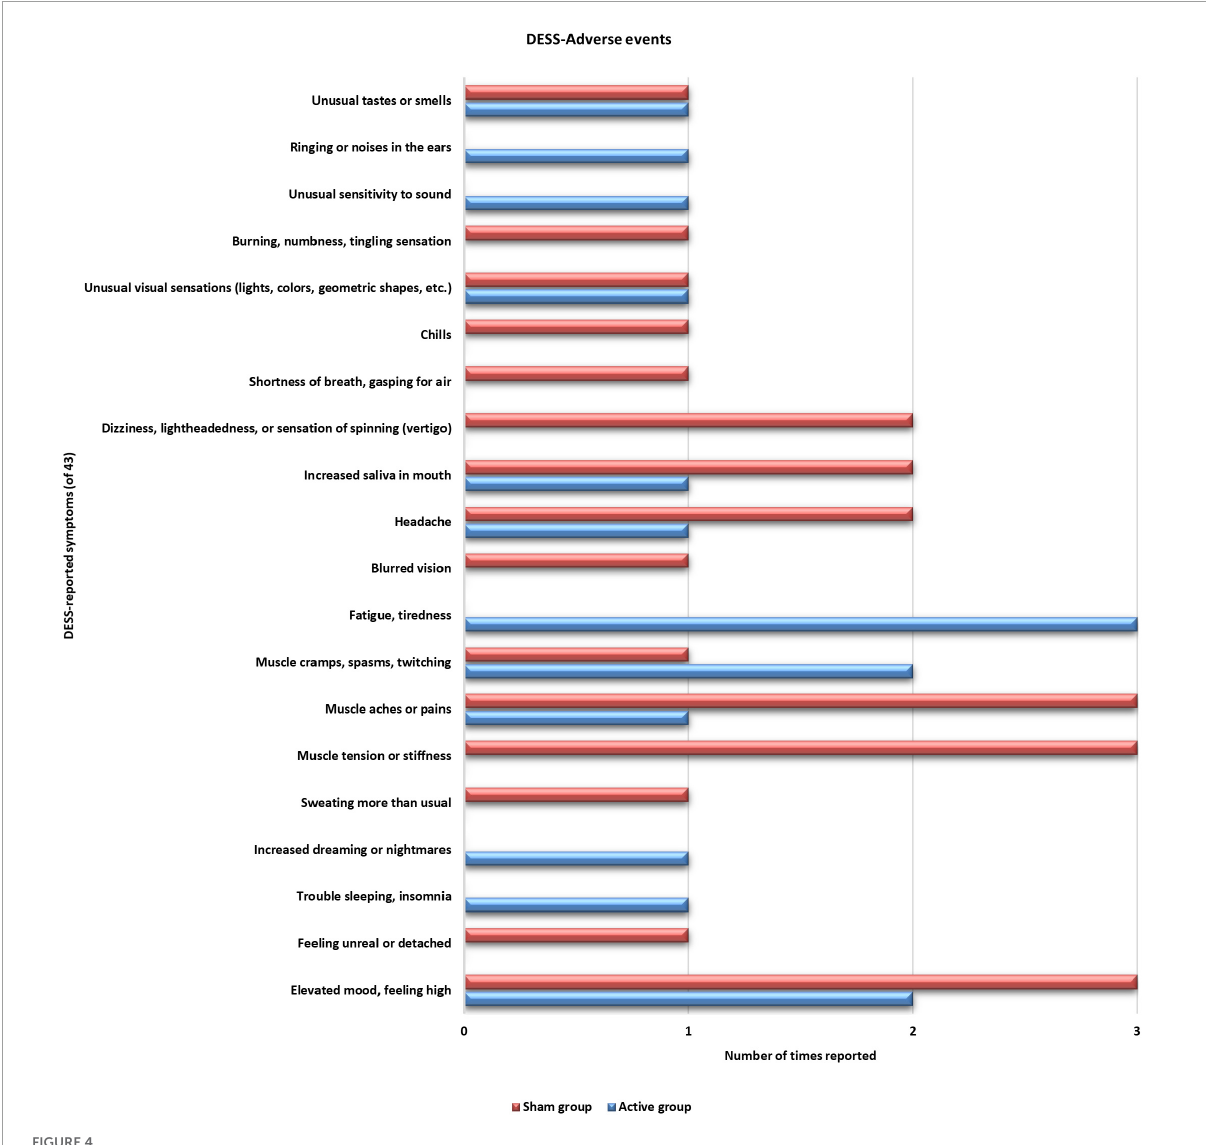
FIGURE4 Distribution of the reported adverse effects by both groups on the Discontinuation-Emergent Sign and Symptom